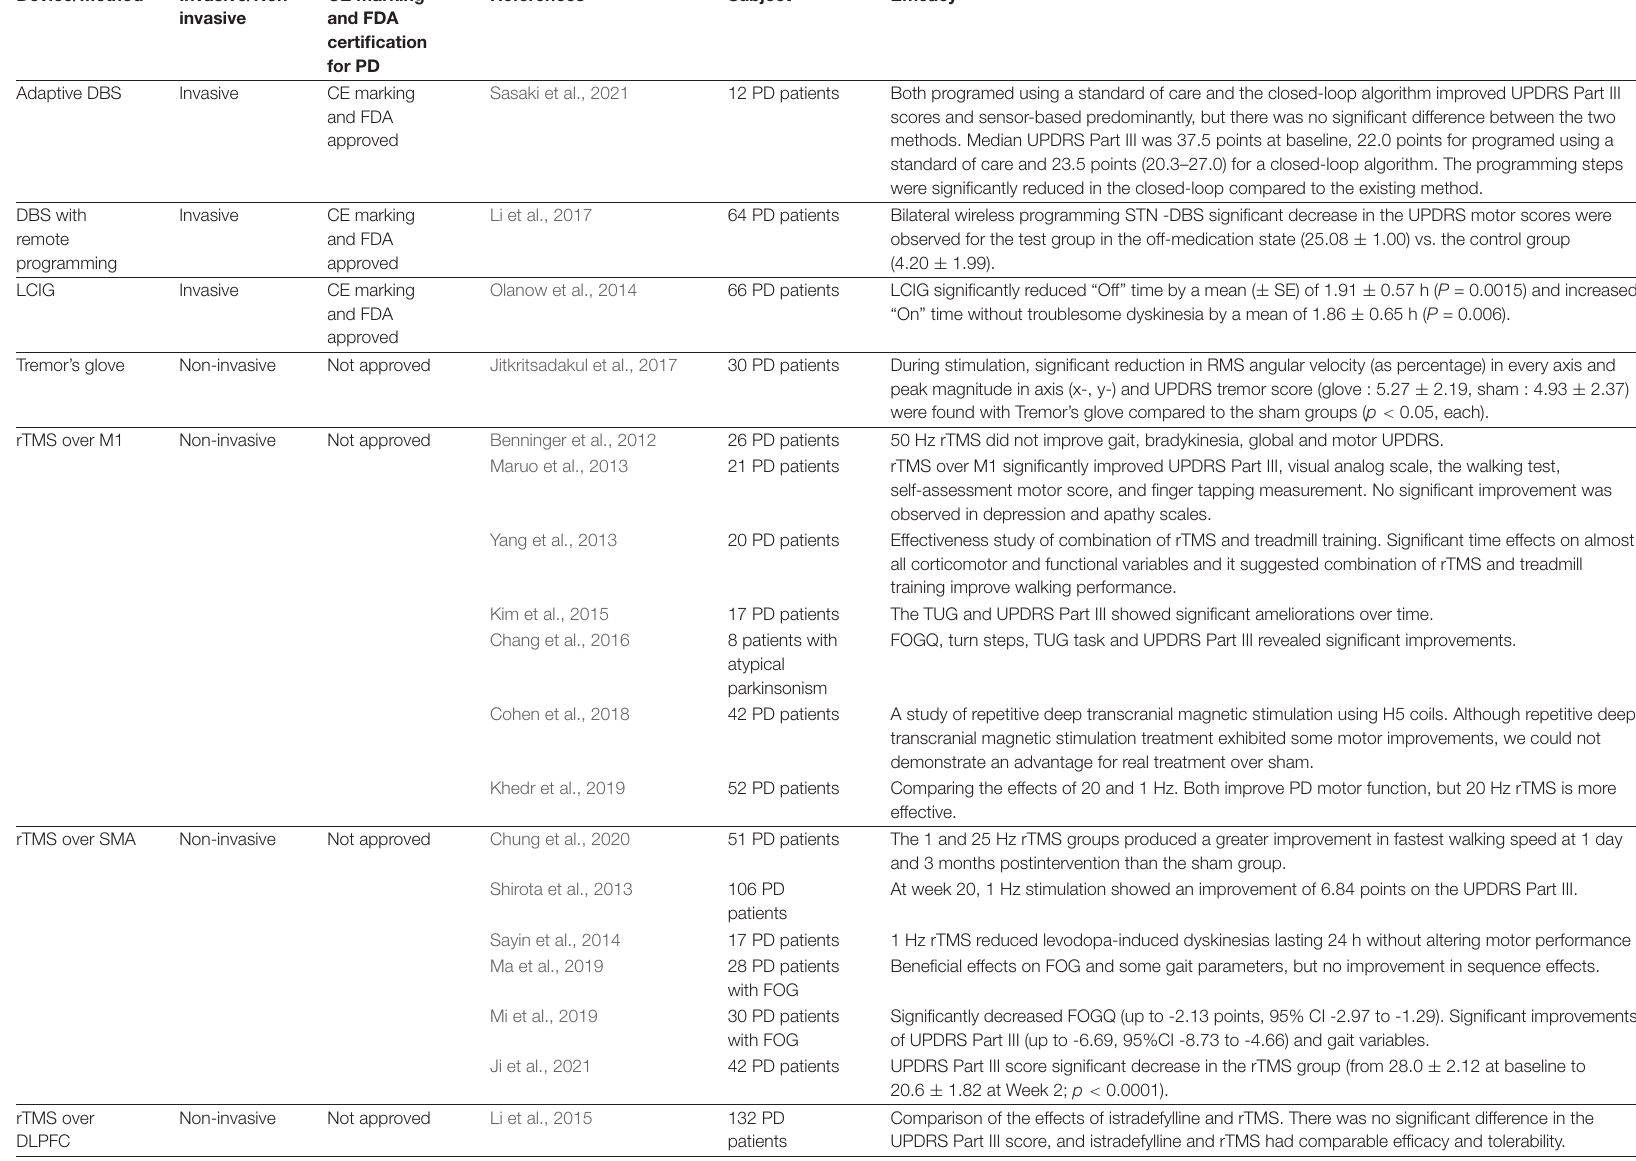
TABLE 1 | Randomized controlled trials of medical